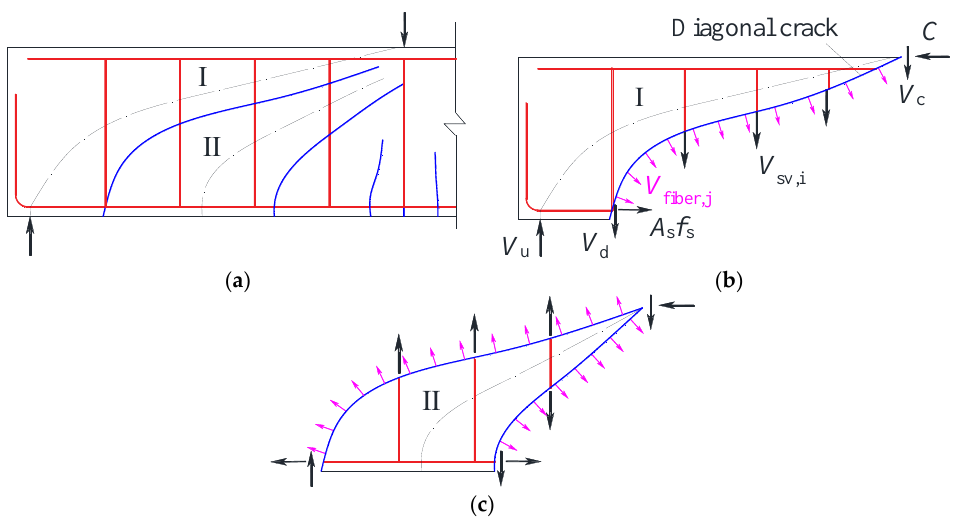
Figure 6. Shear resistance mechanism of RHDC beams with stirrups: ( a ) arch–truss model; ( b ) main arch ( Ⅰ ) and truss elements; ( c ) secondary arch ( Ⅱ ) and truss elements.